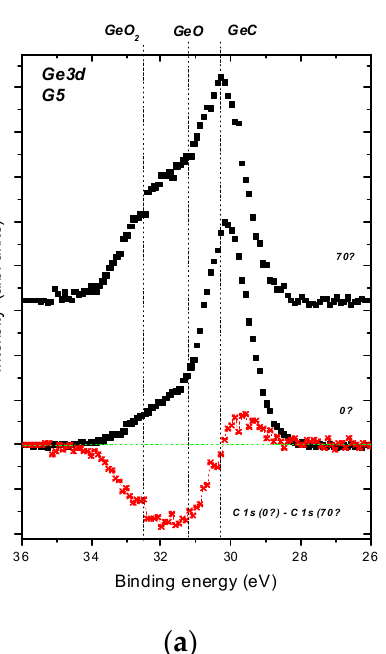
6 of 10 Figure 3. Percentage of Ge species in a surface region of the samples derived from XPS spectra evaluated from ID = 6 nm and 2 nm ( a ). Low energy ion scattering spectra (ID < 1 nm) recorded from undoped DLC G0 and Ge-doped DLC G1 − G5 samples, ascribed to 4He ion beam scattering at Ge atoms ( b ). Note that no Ge content is found for the G1sample using the more surface-sensitive mode when ID = 2 nm. This means the formation of a carbon capping film covering the surface of the sample. Ge concentration values calculated for both ID values are substan- tially lesser than the WDS data. This indicates that a near-surface region of the DLC:Ge layers is Ge-depleted, in agreement with the data in Table 1. The sensitivity of LEIS for a light element as carbon is relatively poor since the ion scattering cross-sections scale with the atomic number. Moreover, a strong matrix effect occurs in low-energy He + ion scattering from carbon, which causes He ion neutralization [40,41]. As a consequence, the spectral signal of He + ions scattered at carbon atoms is very weak. However, the spectral signal induced by 4 He ions scattered from Ge atoms can be easily recorded, see Figure 3b. A peak at about 830 eV is ascribed to ion scattering at Ge atoms [39,42]. Indeed, the spectral signal intensity from Ge atoms increased with the Ge content in a surface region of the analysed samples. Their peak areas 312, 941, 1226, and 1293 (in arbitrary units) for the G2 − G5 samples, respectively, compare well with the Ge content derived from XPS spectra shown in Figure 3a and in Table 1. We underline that no spectral signal from Ge atoms is detected for the G0 sample (as expected) and for Ge- doped G1 sample. This verifies the formation of the carbon capping film at the surface of the G1 sample, as we already deduced from Figure 3a. The capping carbon film thickness t can be estimated in the range of 2 nm ≤ t < 6 nm. As shown in Figure 2b, chemical bonds of germanium atoms and their in-depth lo- cation can be deduced from the Ge 3d photoelectron spectra. The Ge 3d spectra recorded from Ge-doped DLC G5 sample at two different emission angles and therefore at different surface sensitivities and their difference are displayed in Figure 4a. The difference shows